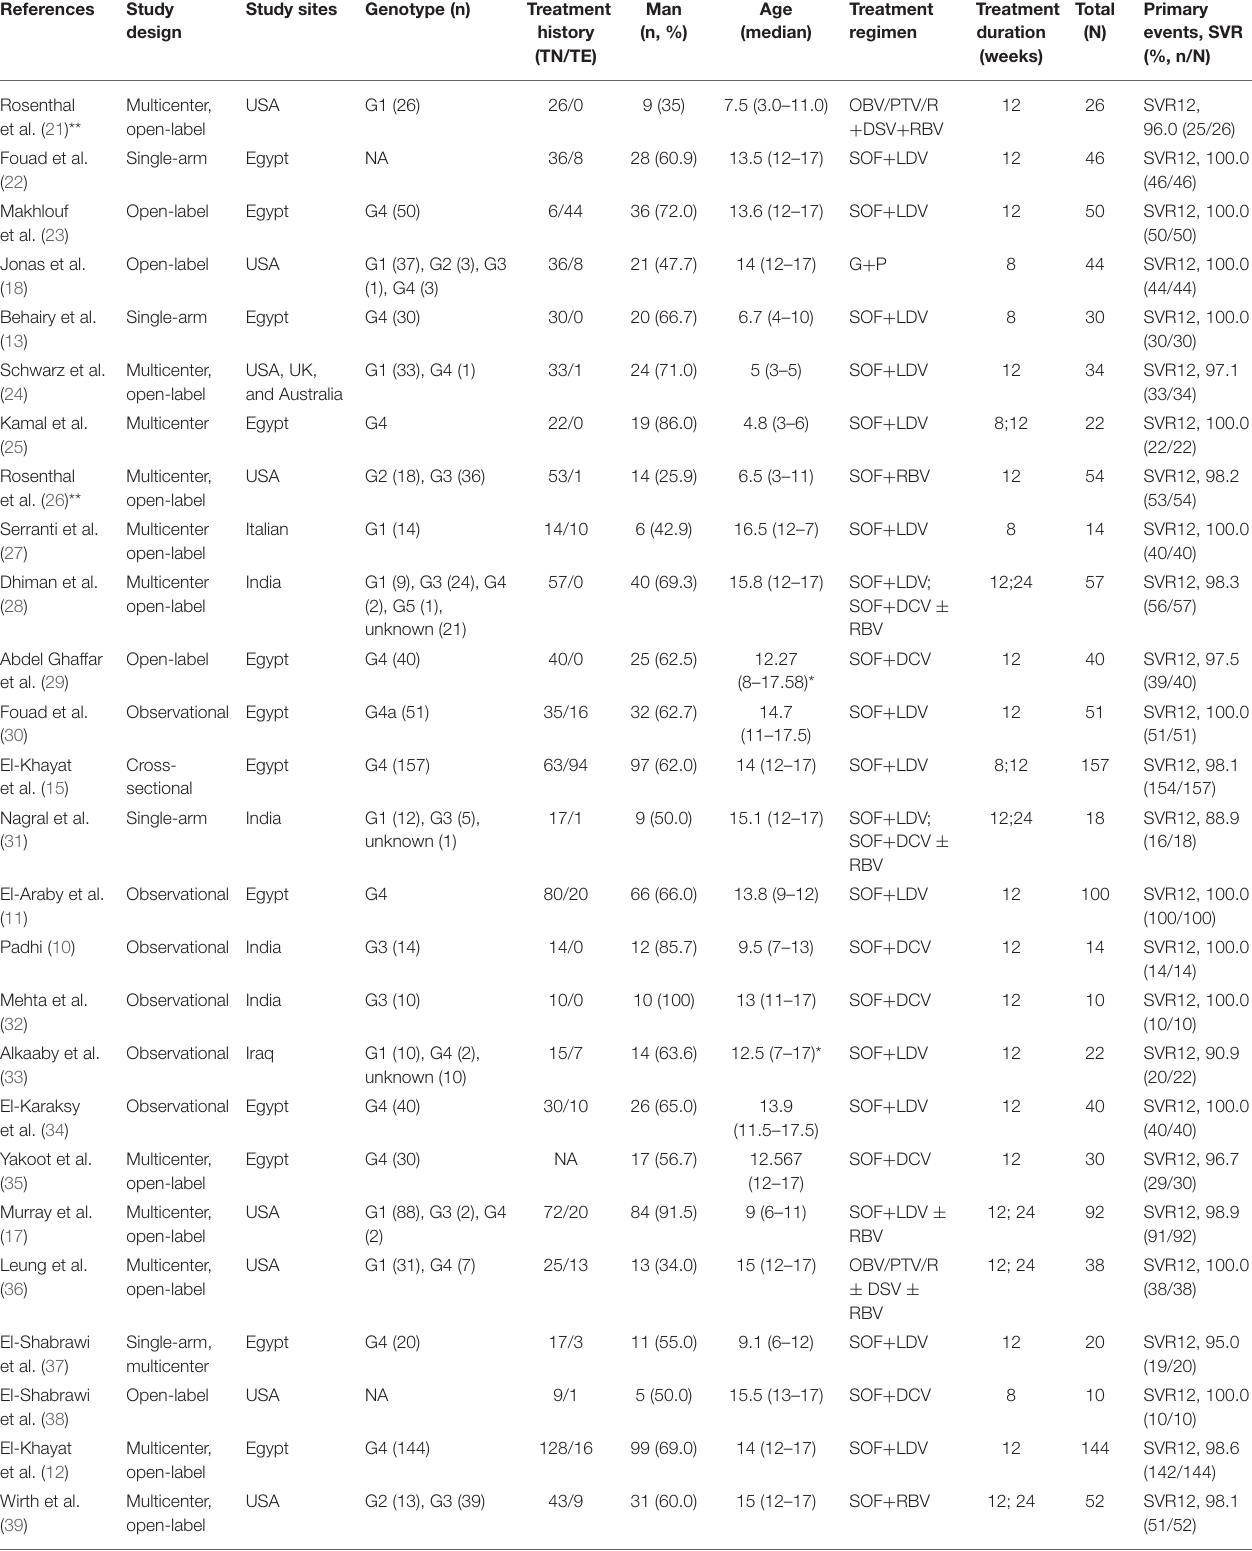
TABLE 1 | Main characteristics of the studies and patients included in this